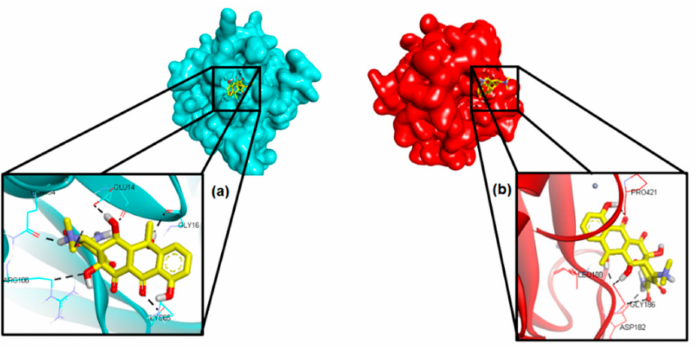
Figure 10. The docking poses OTC at the binding site of ( a ) PEX9 domain and ( b ) its catalytic